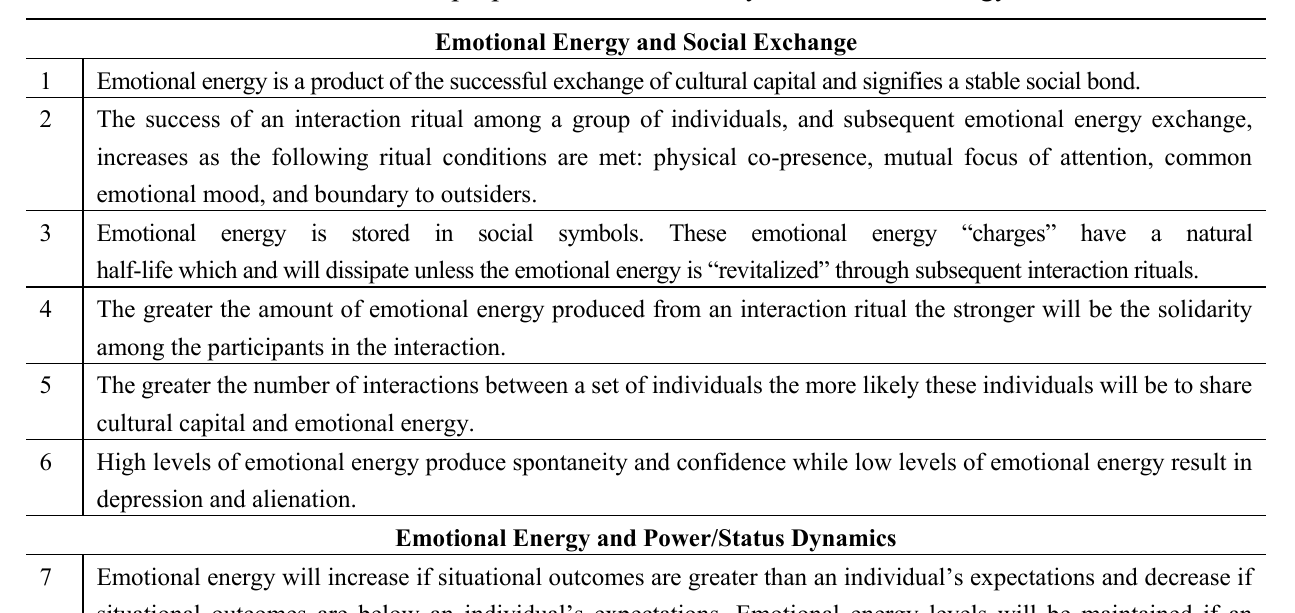
Table 1. Core propositions of the theory of emotional